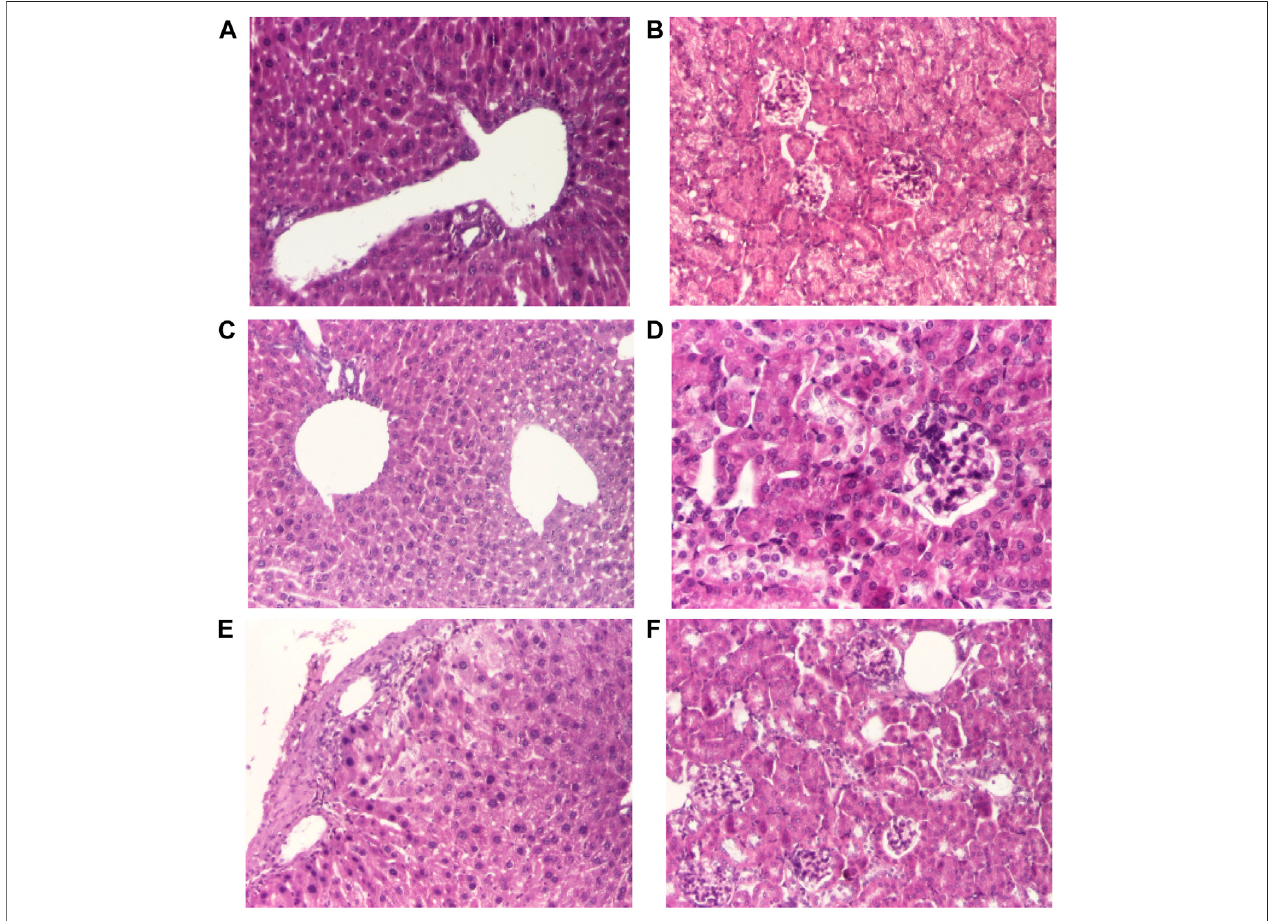
FIGURE 3 | Histological changes of the main organs in the dead mice after doses of 690 mg/kg of Fc (A, B) and F10 (C, D) and after doses of 1,090 mg/kg of F10 (E,F) .Representativepicturesfrom HEstainingsections oftheliver(hematoxylin-eosinHE stain, × 100) (A,C,E) ,renal(hematoxylin-eosinHE stain, × 100) (C,D,F) .